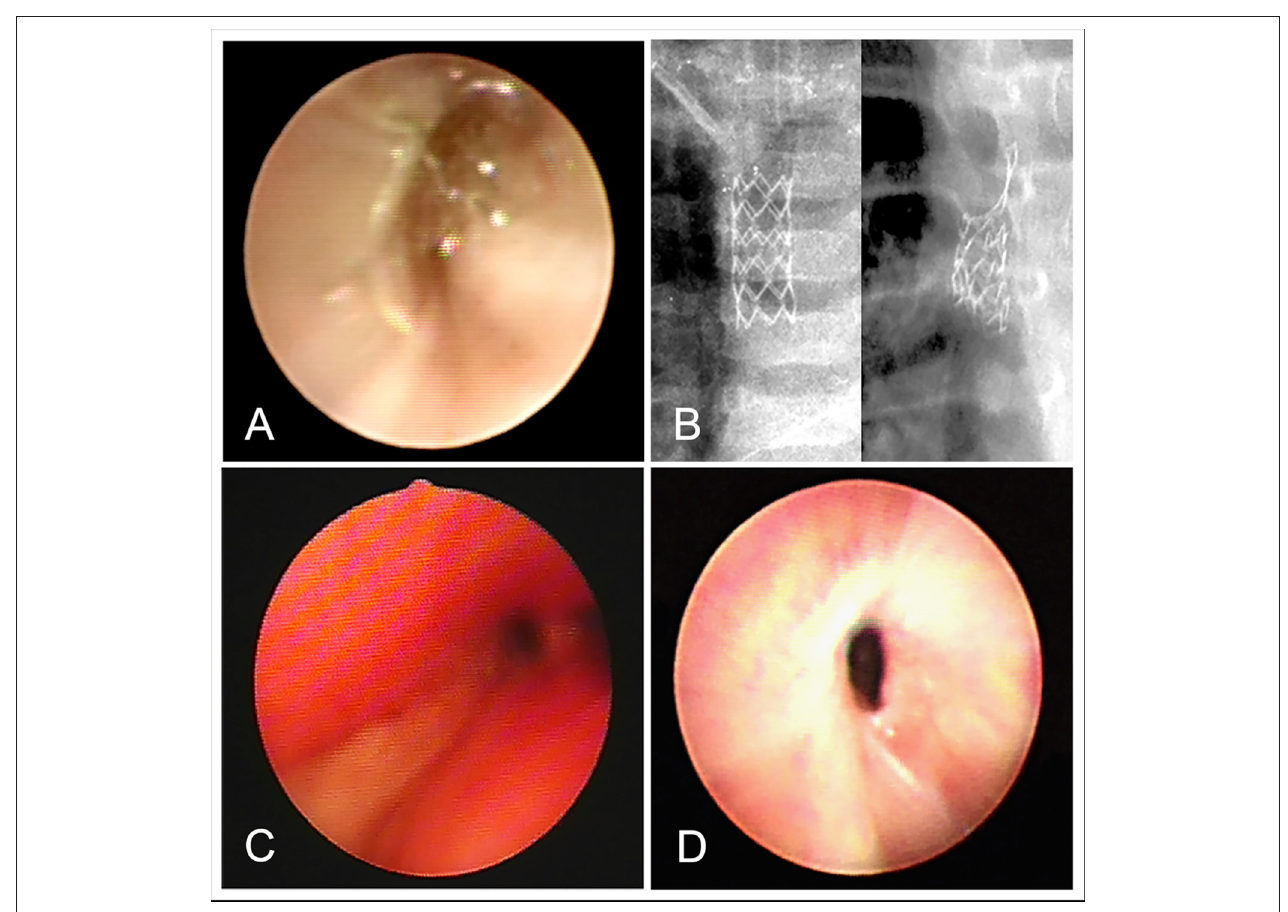
FIGURE 1 | (A) Stent deformation. (B) Stents breakage. (C) Increase of secretion. (D) Granulation tissue hyperplasia.